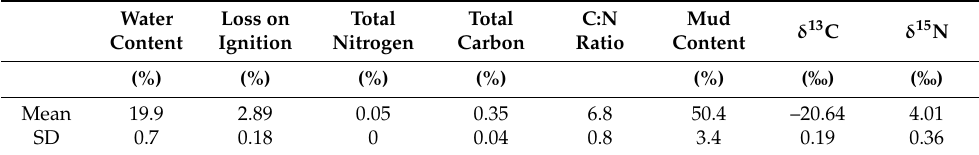
Table 2. Environmental characteristics of the Yubu Island tidal flat in the western coastal area of South Korea.